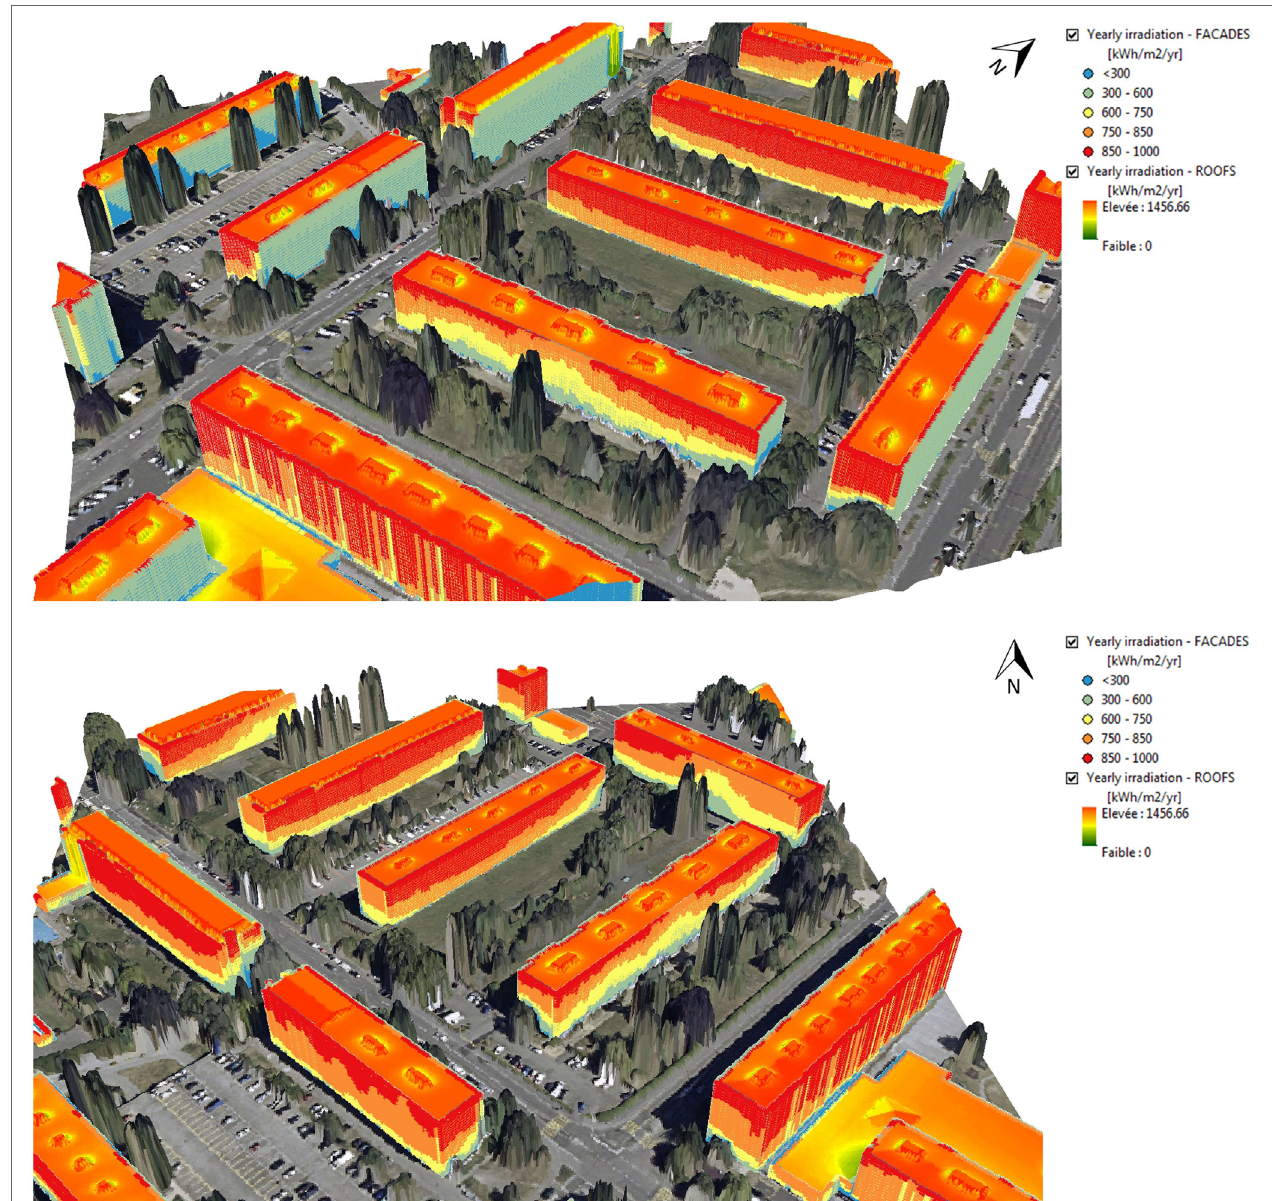
FIGURe 9 | 3D representations of the solar radiation outputs (in kWh/m 2 /year) on existing building facades and roofs in the “Meyrin Cité” neighborhood (Geneva), showing two different expositions; adapted with permission from © 2016 IEEE (Boulmier et al.,